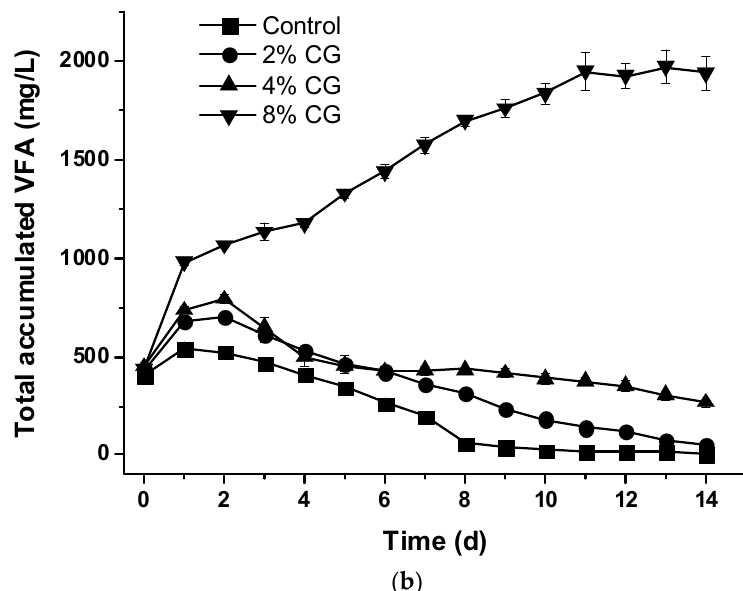
Figure 5. ( a ) Daily pH value and ( b ) accumulated total volatile fatty acid of adding different percentage of crude glycerol.